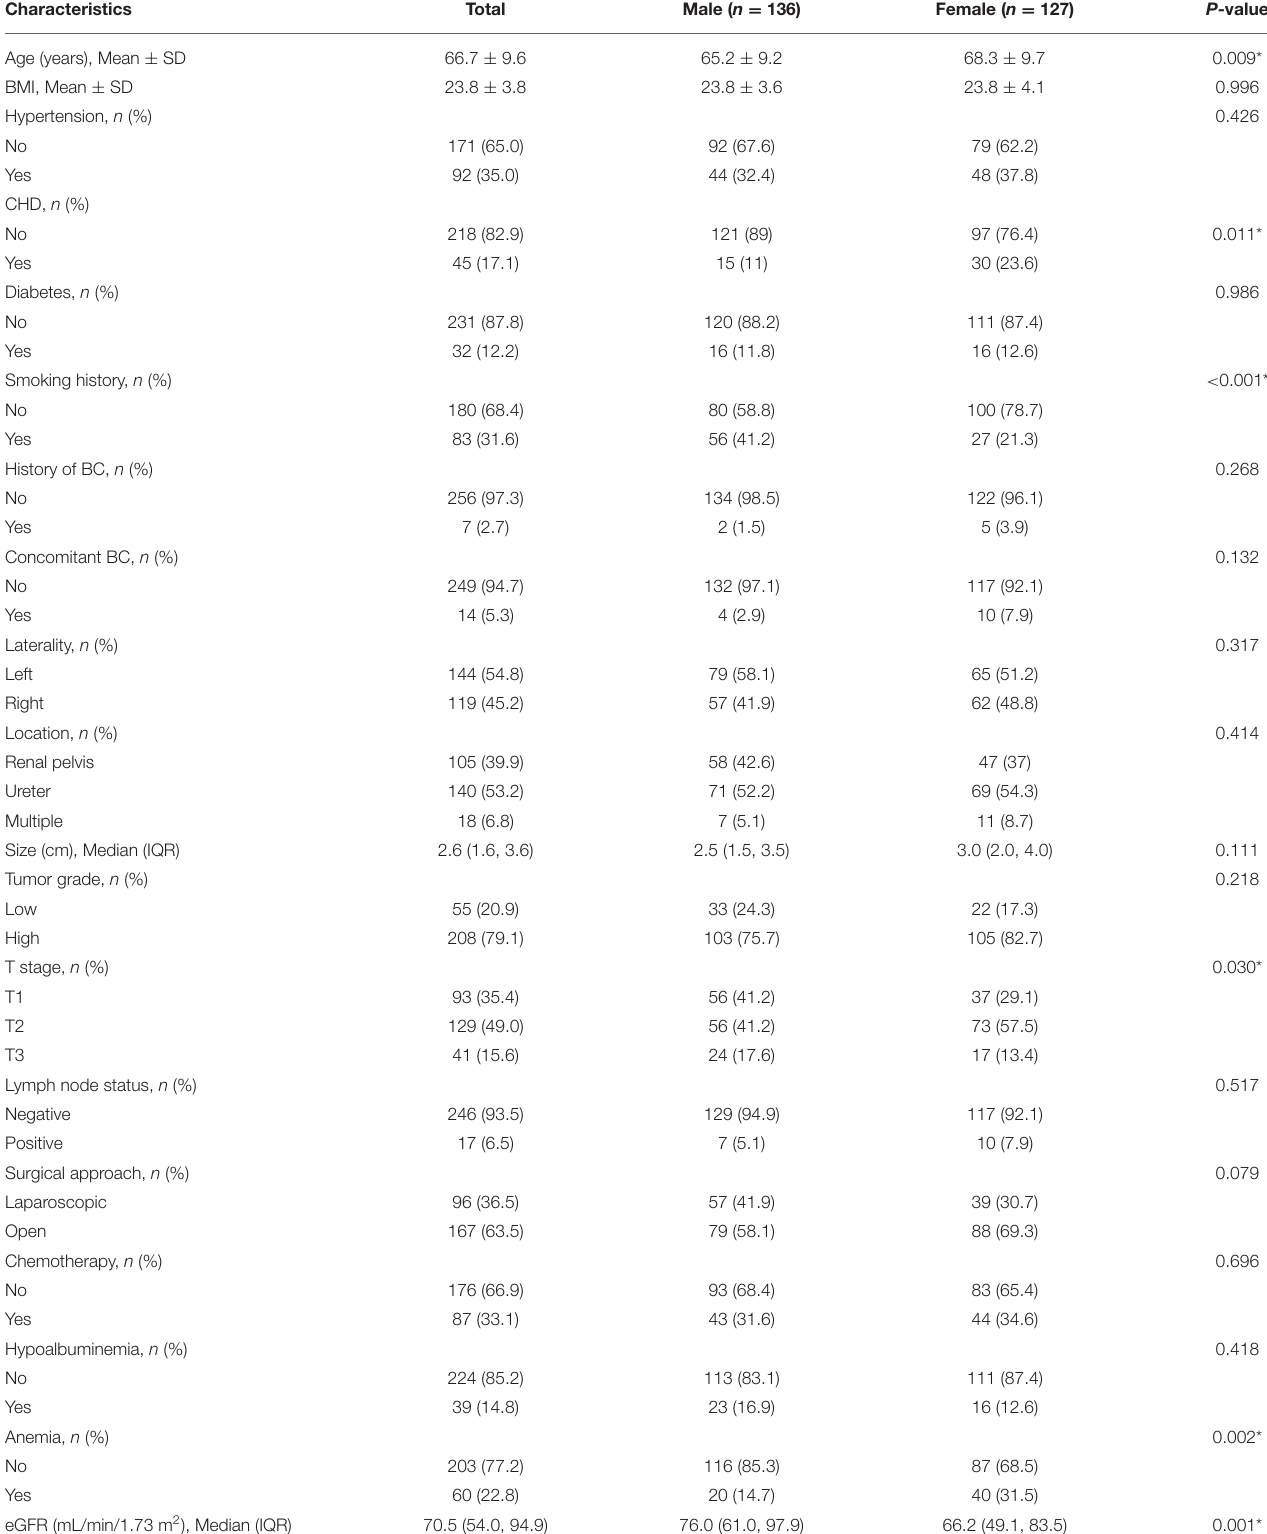
TABLE 4 | Association of sex with clinical and pathological characteristics in UTUC patients treated with RNU ( n = 263).